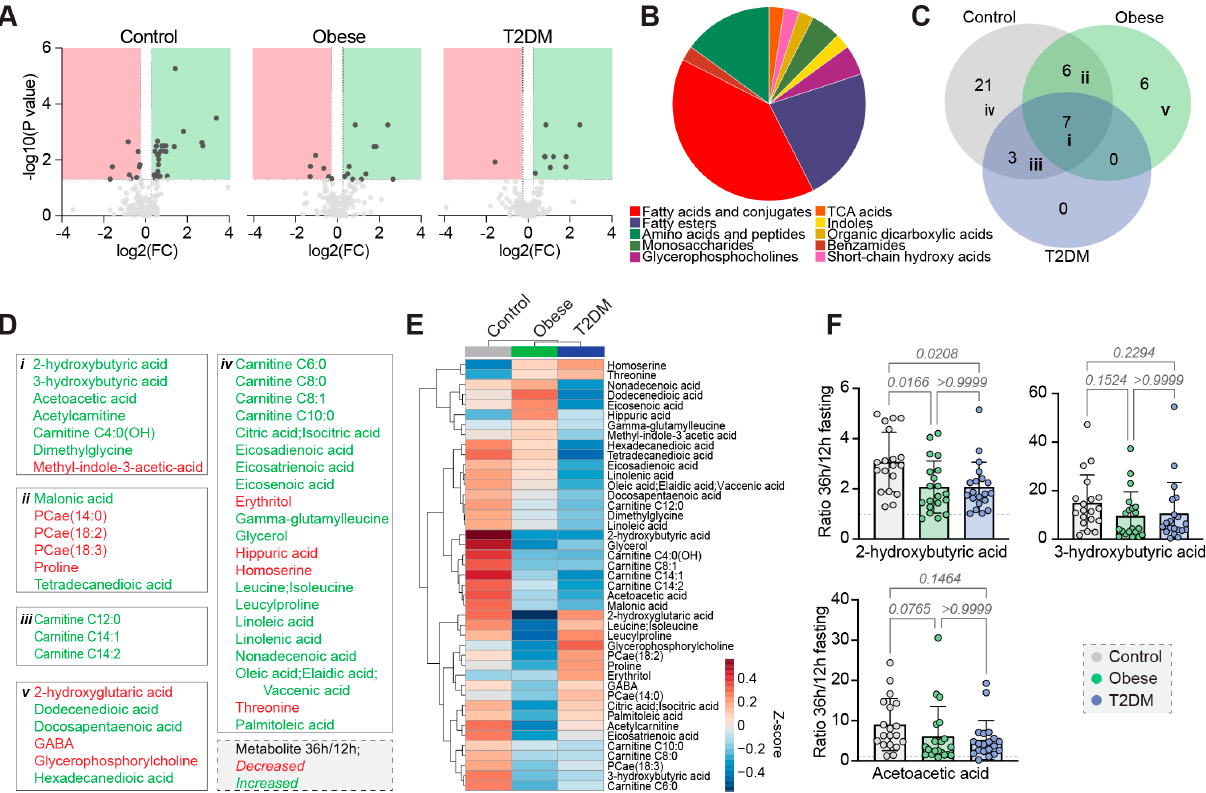
Figure 3. Differences in the metabolomes after prolonged fasting. ( A ) Volcano plots of fastinginduced changes in the metabolome. FC = fold change. ( B ) Classification of significantly different metabolites. ( C ) Venn diagram of the identified fasting-responsive metabolites. ( D ) All fasting-responsive metabolites allocated to the groups of the Venn diagram. ( E ) Heatmap of the fasting-responsive metabolites, showing cohort averages. ( F ) Group comparisons of the ratios of selected metabolites.